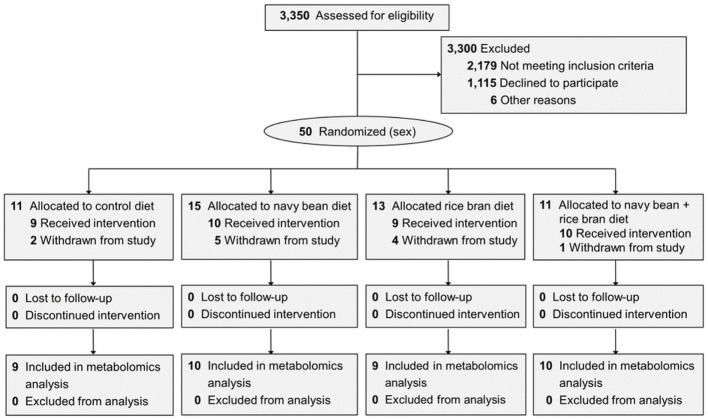
Participants in each dietary intervention group and the plasma samples used for metabolome analysis. CONSORT diagram shown in Borresen et al. (27). Reasons for withdrawal included: noncompliance to the study protocol (n = 5), declined to participate (n = 6), and gastrointestinal issues (n = 1).